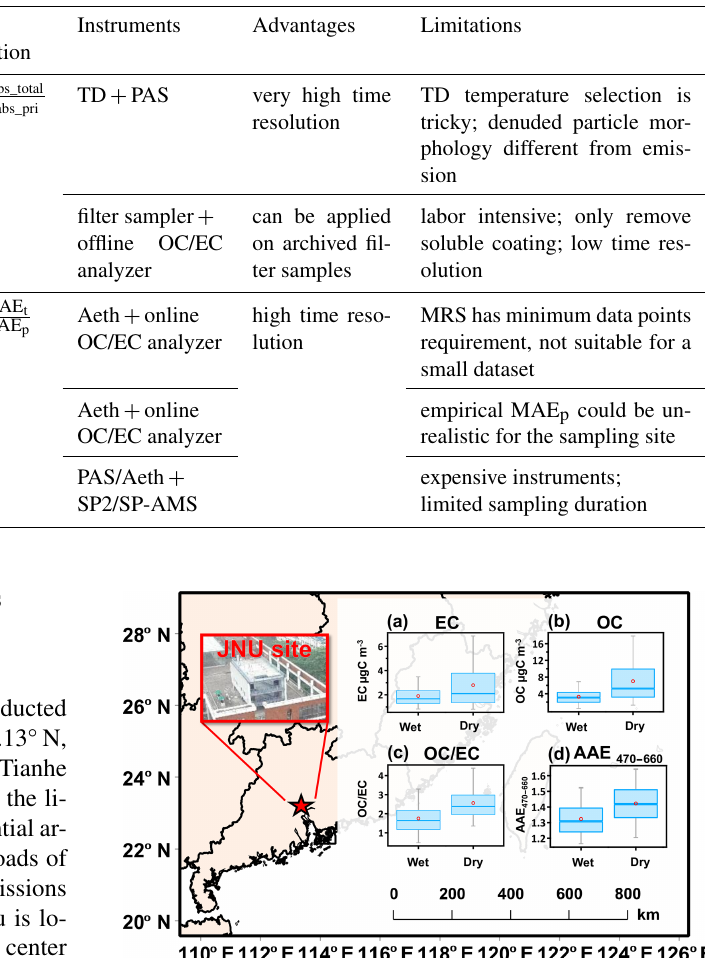
Figure 1. The location of the observation site (JNU). Panels (a) , (b) , (c) and (d) show the box plots of EC, OC, OC / EC and AAE 470–660 during wet (July–September) and dry (November–January) seasons, respectively. Red circles represent the seasonal average. The line inside the box indicates the median. Upper and lower boundaries of the box represent the 75th and the 25th percentiles; the whiskers above and below each box represent the 95th and 5th